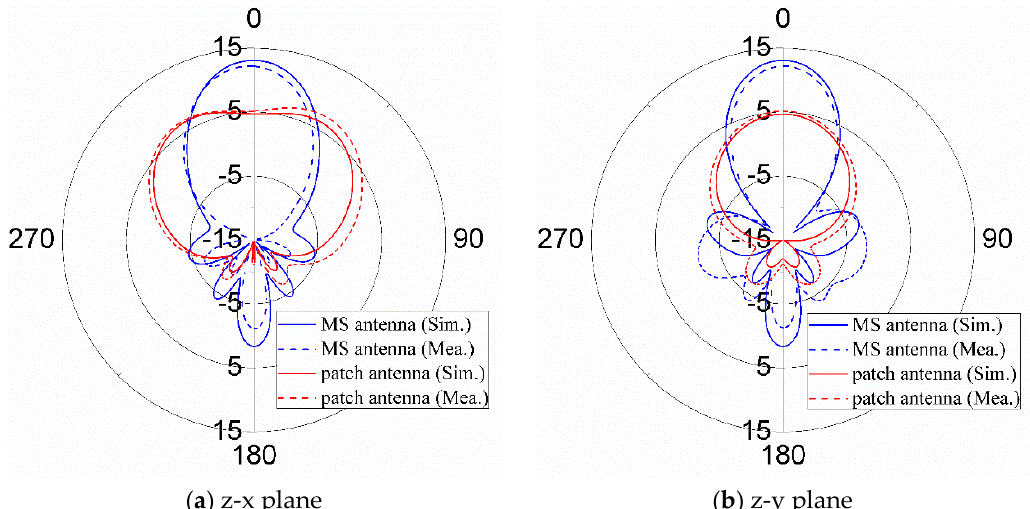
Figure 13. Simulated and measured radiation patterns.